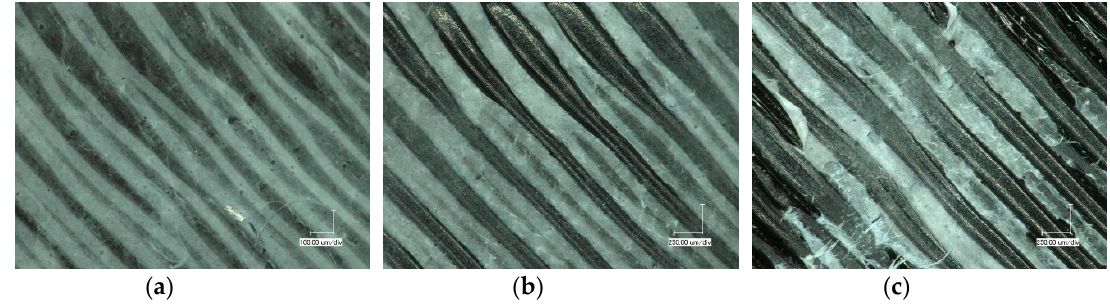
Figure 9. Composite surface after Martindale abrasion tests, ( a ) before the test, ( b ) after 10 cycles in dry state, and ( c ) after 50 cycles in dry state.